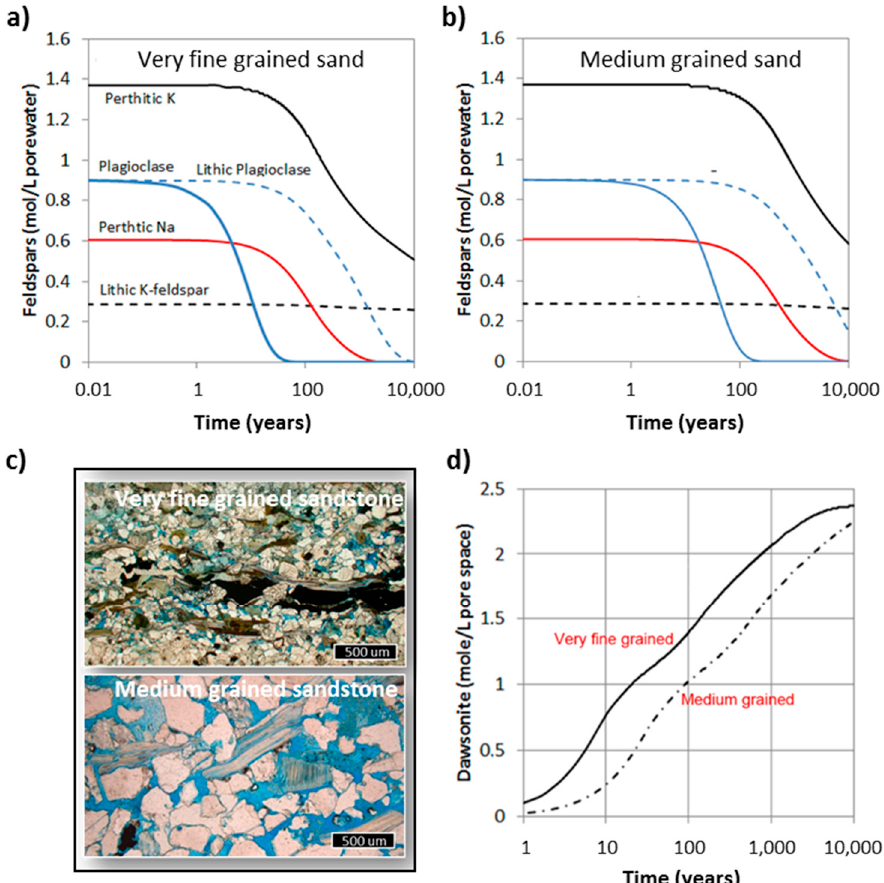
Figure 8. Simulated feldspar dissolution of equal wt% feldspars for ( a ) very fine grained sand, and ( b ) medium-grained sand. Feldspars were divided into perthitic K- and Na-feldspars, K-feldspar and plagioclase in lithic fragments, and detrital plagioclase grains; ( c ) micrographs from corresponding facies in the Johansen Formation: very fine grained and medium grained sandstones. Pore space is filled with blue epoxy; ( d ) amount of dawsonite that forms from feldspar dissolution for very fine grained and medium grained sand lithologies. The two cases correspond to ( a ) and ( b ) (this figure).